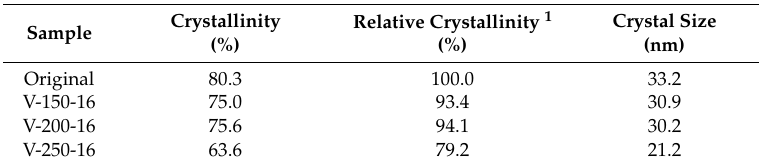
Figure 2. X-ray diffraction (XRD) patterns of the NH 2 -MIL-125(Ti) treated under vacuum at different temperatures for 16 h. The original NH 2 -MIL-125(Ti) pattern is included as reference. Table 1. Crystallinity percentages and crystal size values of NH 2 -MIL-125(Ti) before and after vacuum treatment at different temperatures for 16 h.